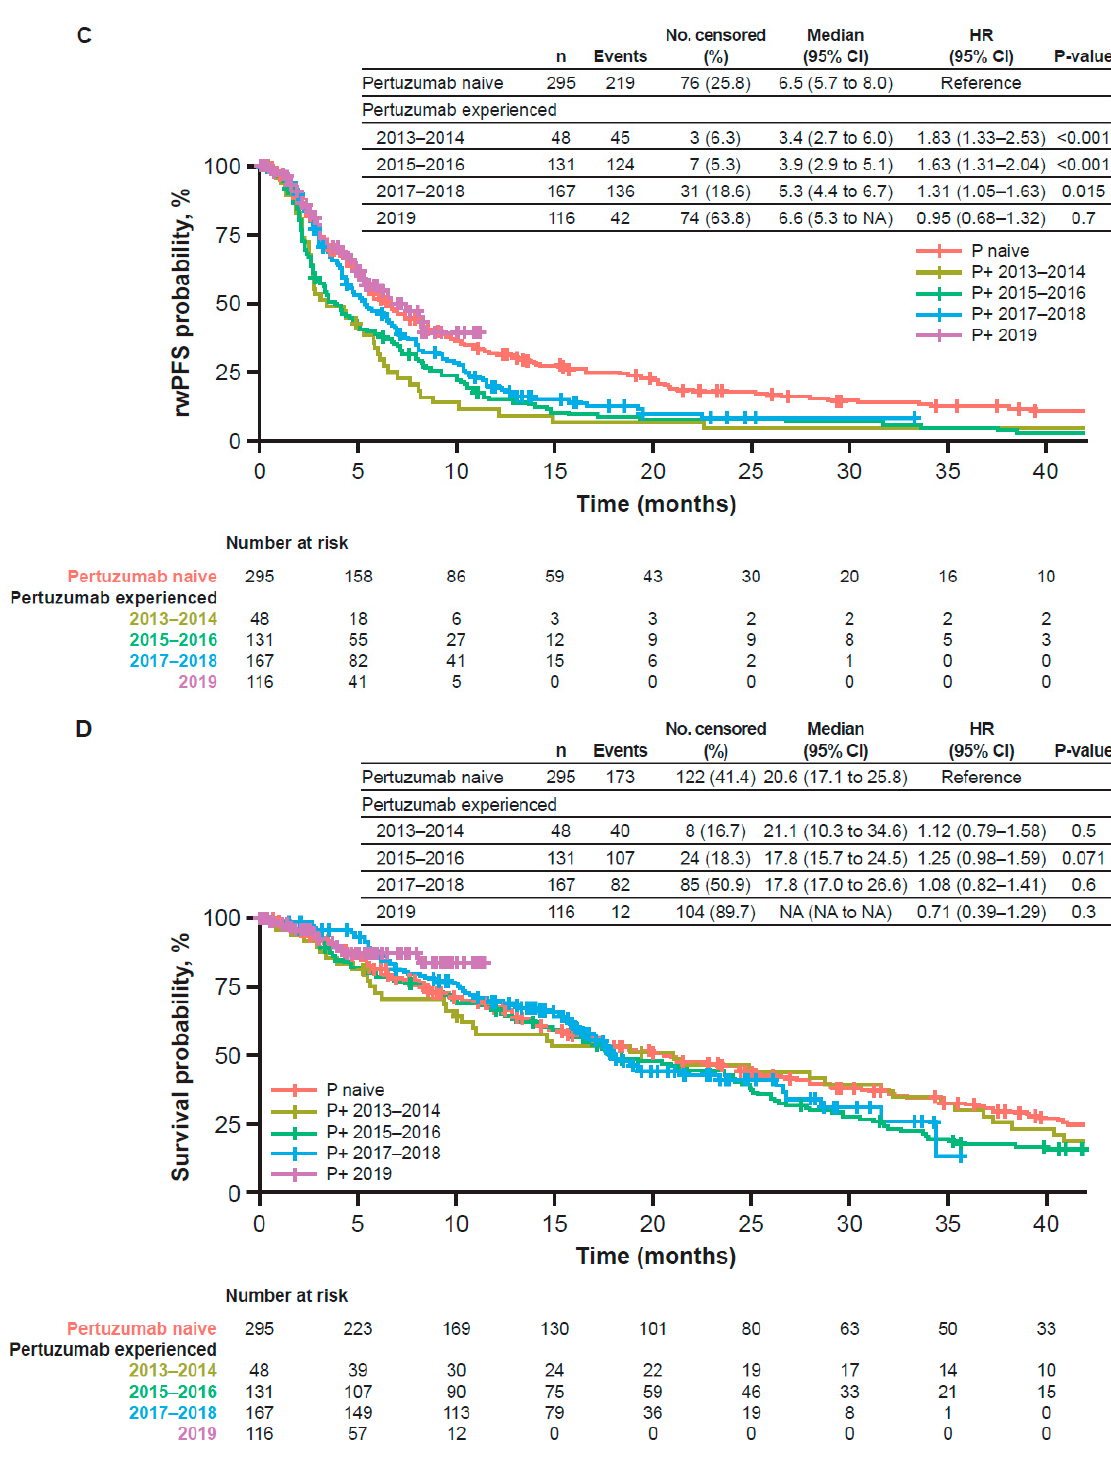
Figure A3. Sensitivity analysis of the effectiveness of T-DM1 in the primary cohort stratified by prior pertuzumab use. ( A ) TTNT or death; ( B ) TTLA of T-DM1 before discontinuation or death; ( C ) rwPFS; and ( D ) OS. The primary cohort consisted of patients who initiated T-DM1 in any treatment line.CI = confidence interval; NE = not estimable; No = number; OS = overall survival; P = pertuzumab; P+ = pertuzumab-exposed; rwPFS = real-world progression-free survival; T-DM1 = trastuzumab emtansine; TTLA = time to last administration; TTNT = time to next relevant treatment.